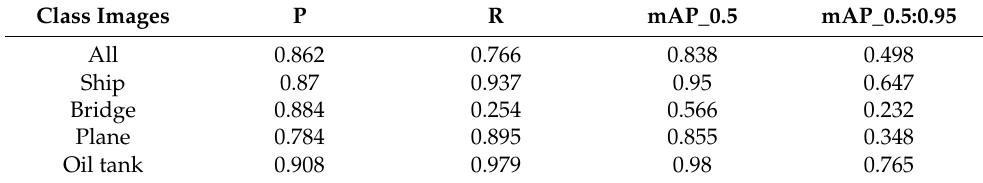
Table 6. Results of SR modified yolov5 in MSAR dataset.